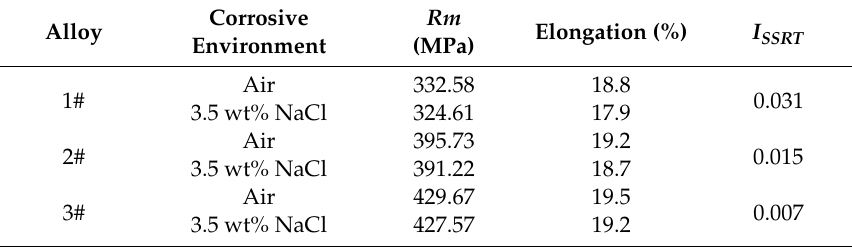
Table 5. Slow strain rate test (SSRT) results (ED direction on ED–TD plane) of alloys with di ff erent Zn / Mg